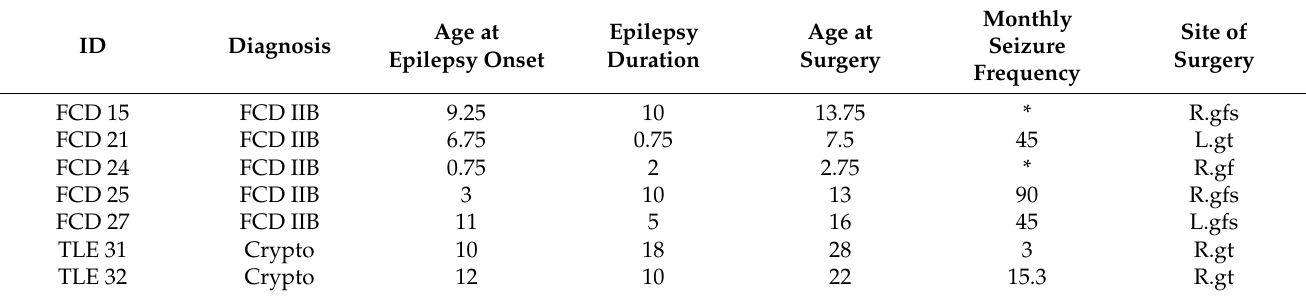
Table 1. Clinical data of the